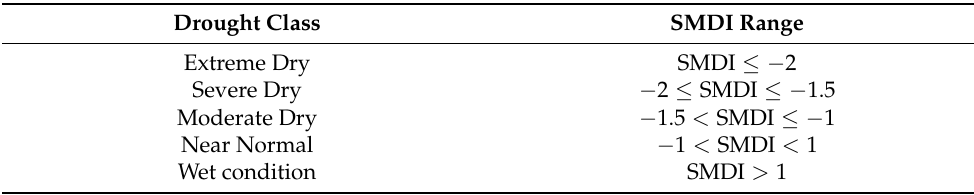
Table 3. Drought classification based on SMDI.